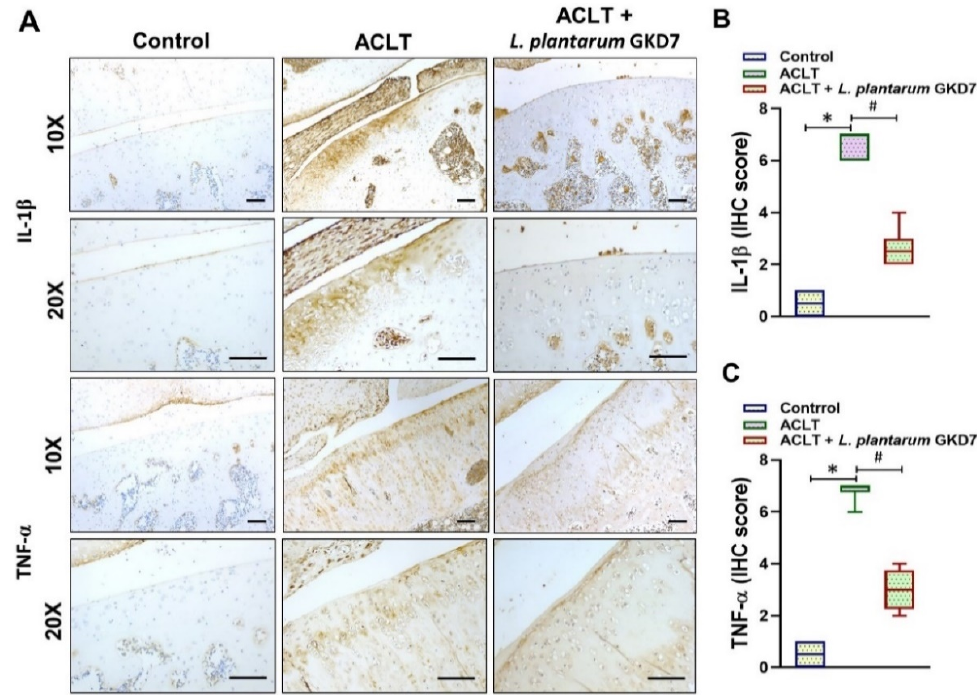
Figure 5. Oral live L. plantarum GKD7 reduced key proinflammatory cytokines in OA cartilage. ( A ) IHC staining of IL-1β and TNF-α expression in representative cartilage from controls, ACLT-only rats, and ACLT + L. plantarum GKD7 rats. Quantitative analyses of ( B ) IL-1β and ( C ) TNF-α in cartilage. Scale bar = 100 µm. * p < 0.05 vs. controls; # p < 0.05 vs. the ACLT-only group.